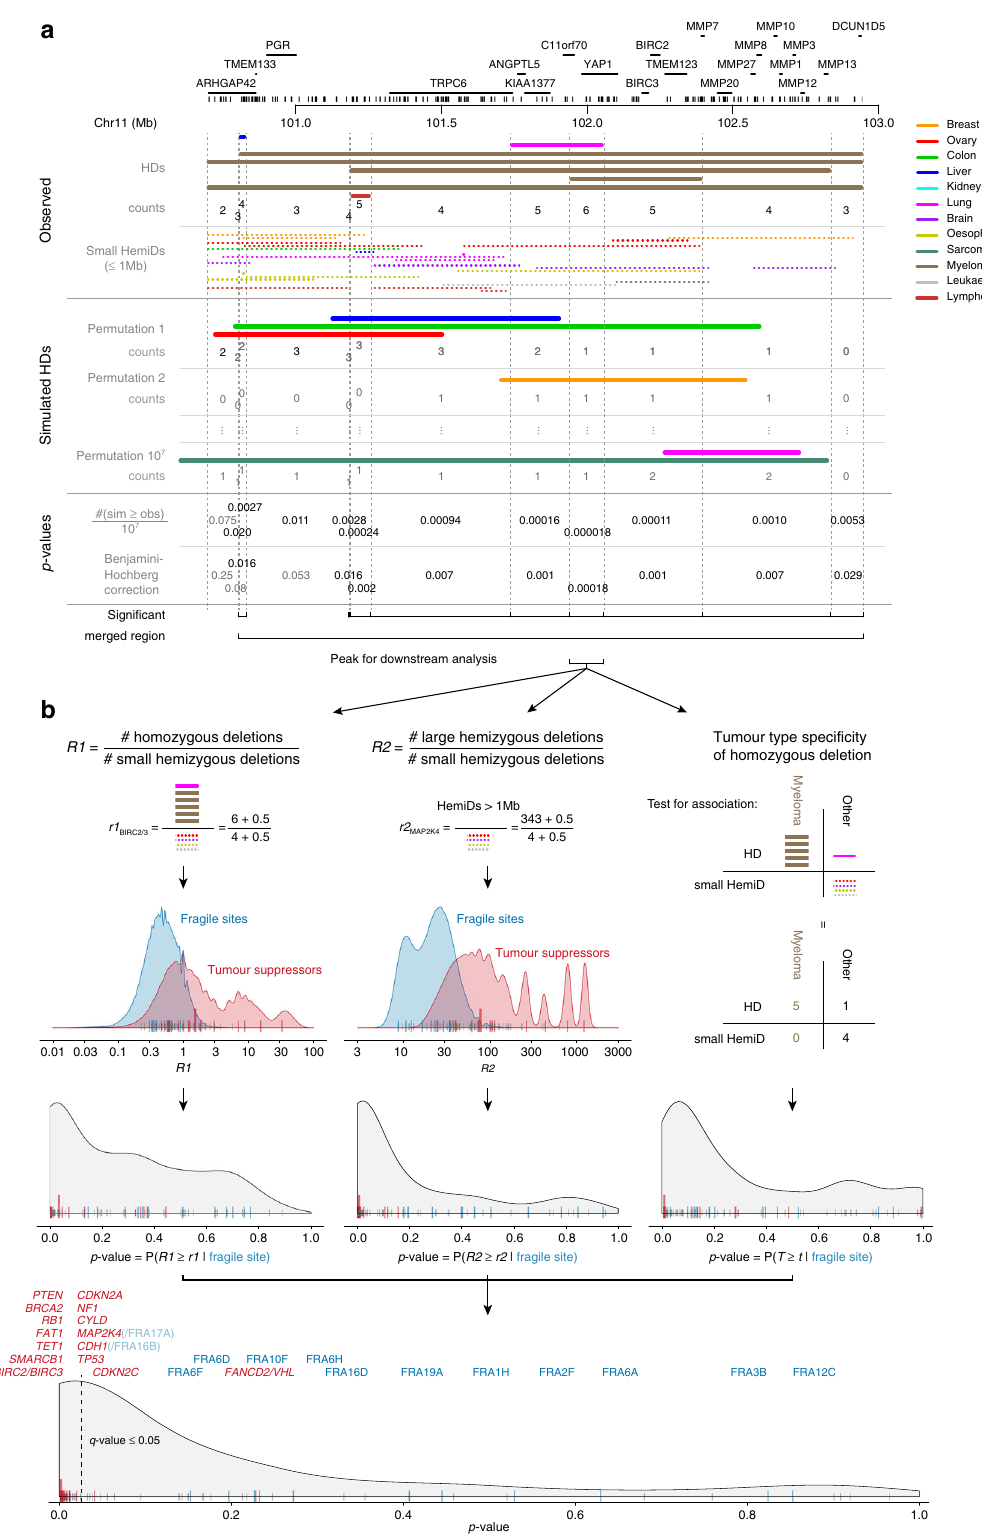
Test for association: